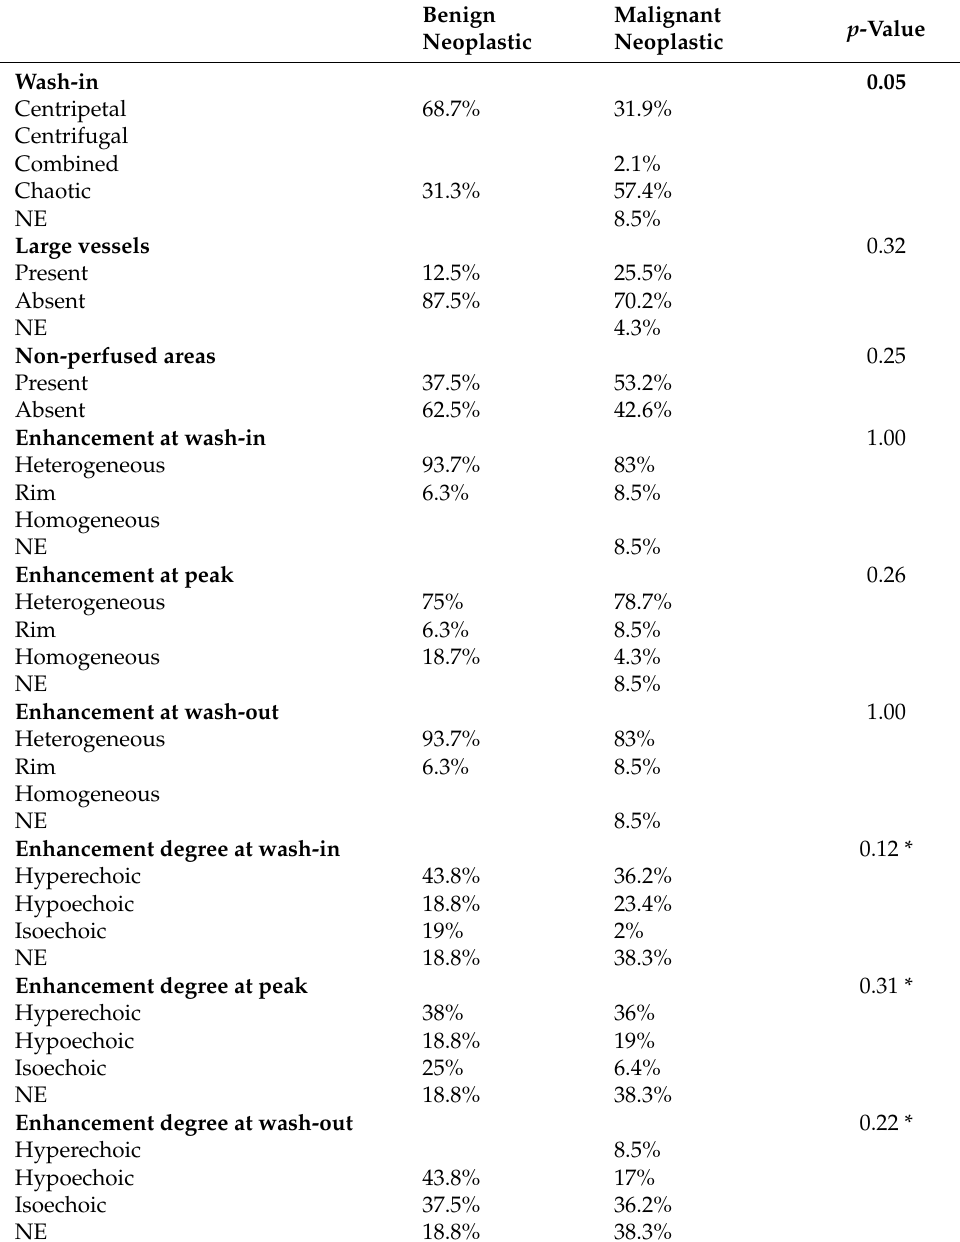
Benign Malignant p -Value Neoplastic Neoplastic